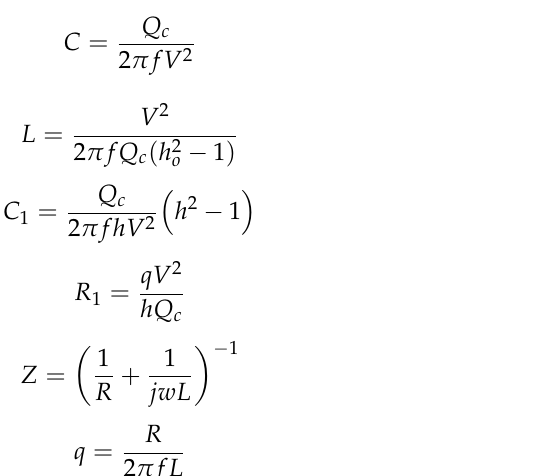
Figure 6. ( a ) C-type filter, ( b ) high-pass filter and ( c ) capacitor bank. The parameters for these filters are determined using Equations (1)–(6) [32], and the parameters are indicated in Table A5 in the Appendix